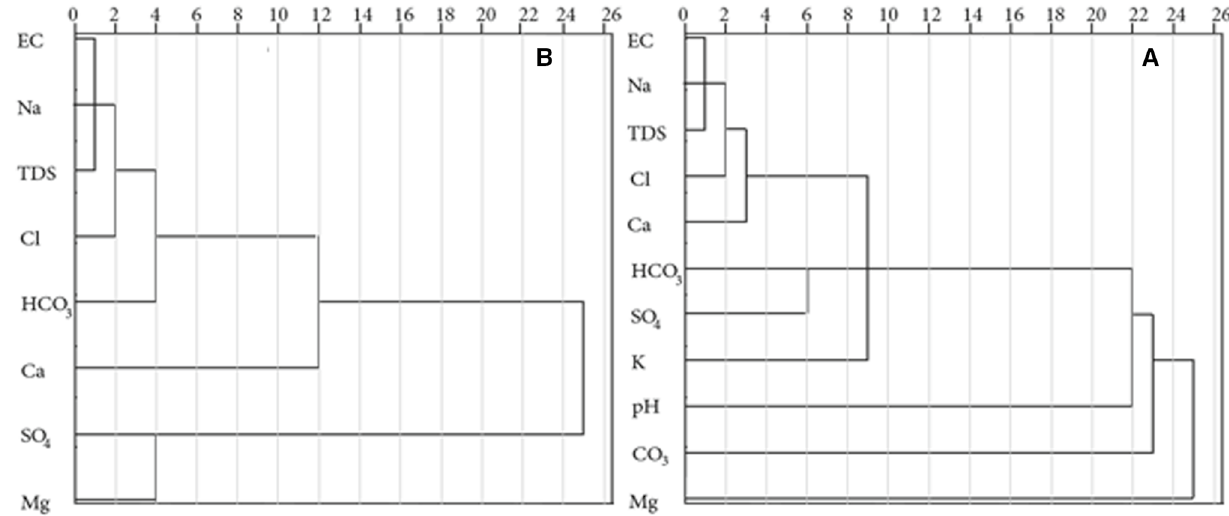
Fig. 4 Dendrogram of the studied parameters of the Karun River in the lake and downstream of the Gotvand-e-Olya Dam; a nearest neighbor method and b wards method (the first-time sampling)